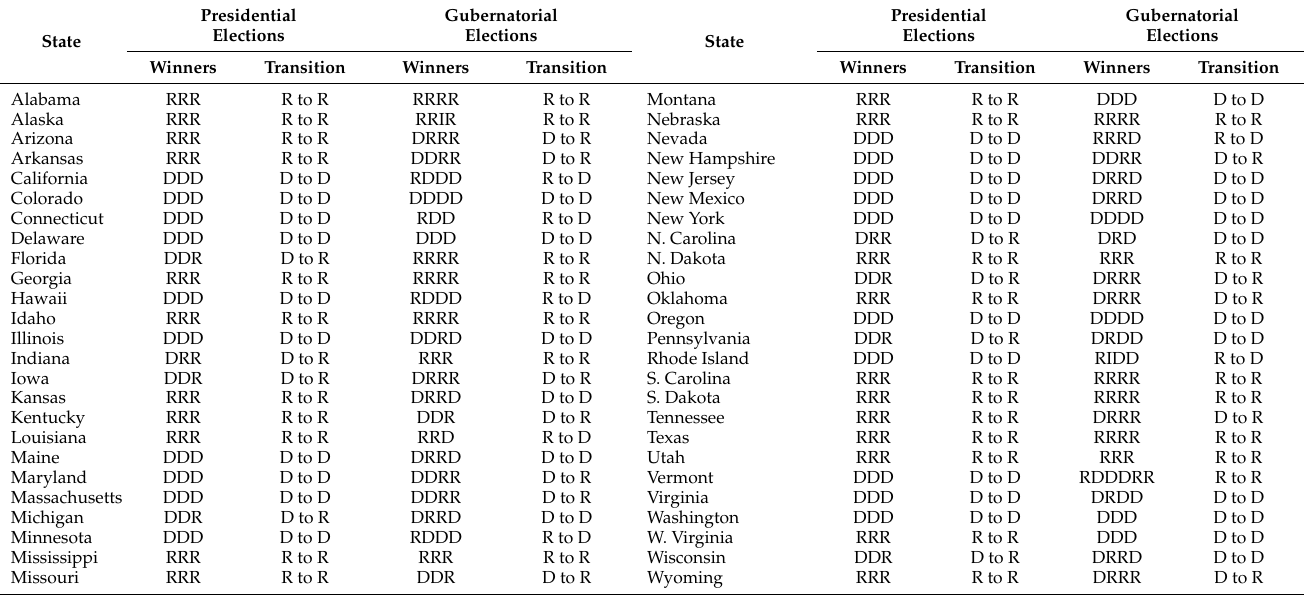
Table 2. States by Results of Presidential and Gubernatorial